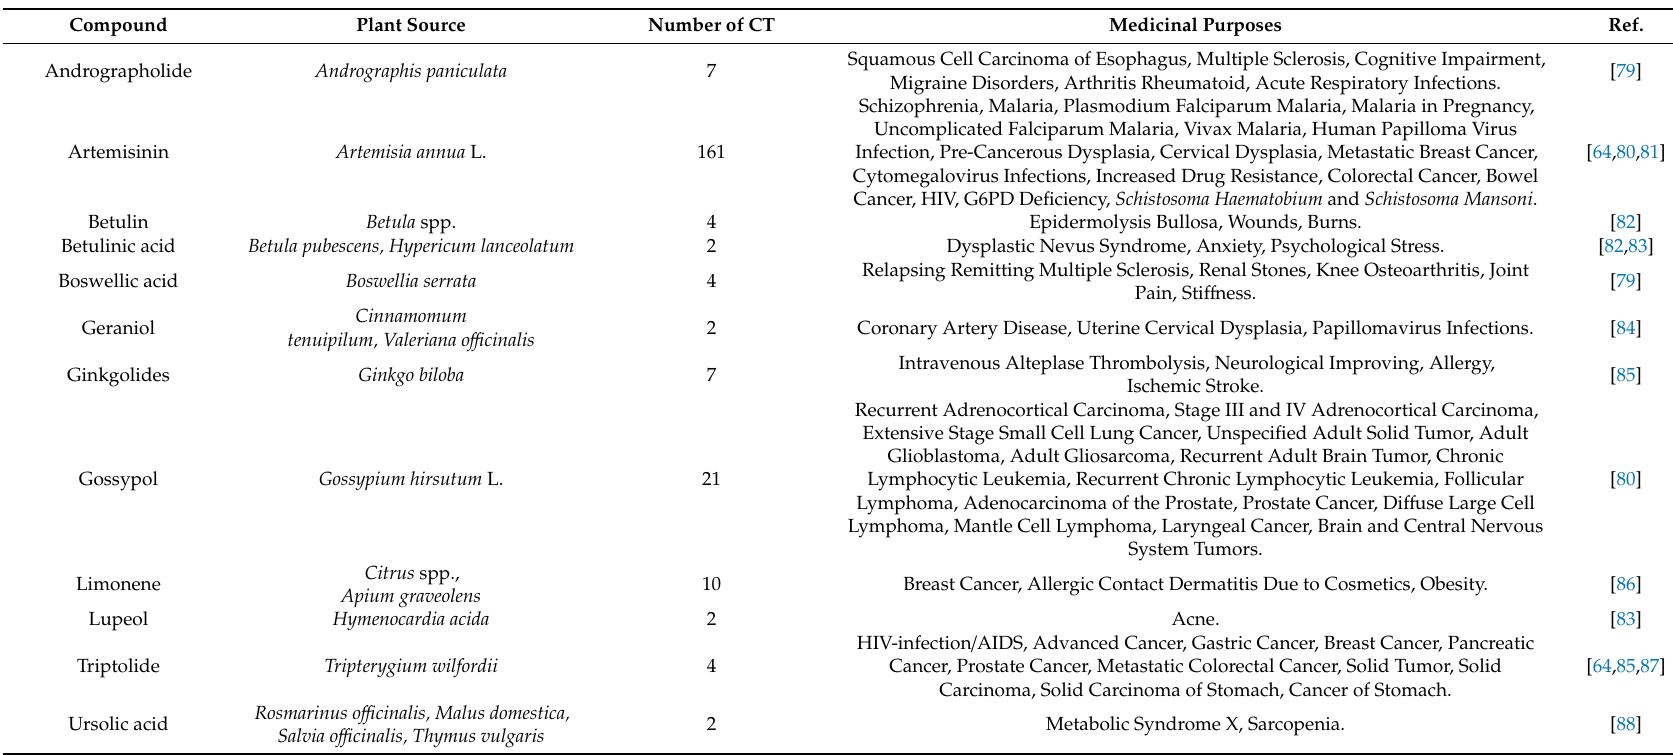
Table 1. Plant-derived terpenes in clinical trials (CT). Includes Not yet recruiting, Recruiting, Enrolling by invitation, Active not recruiting, Suspended and Completed trials of these compounds, parent extracts, or derivatives, applied alone or as a mixture with other constituents. Determined from www.clinicaltrials.gov on